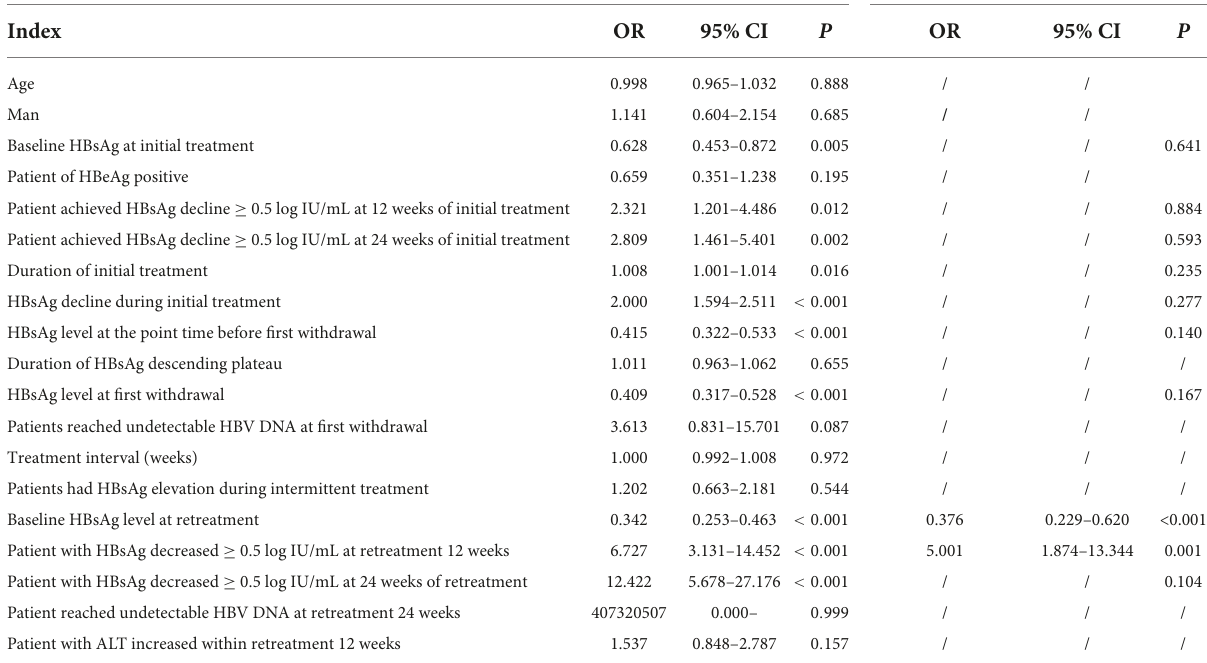
TABLE 2 Logistic regression analysis of related factors of HBsAg disappearance. Univariate logistic